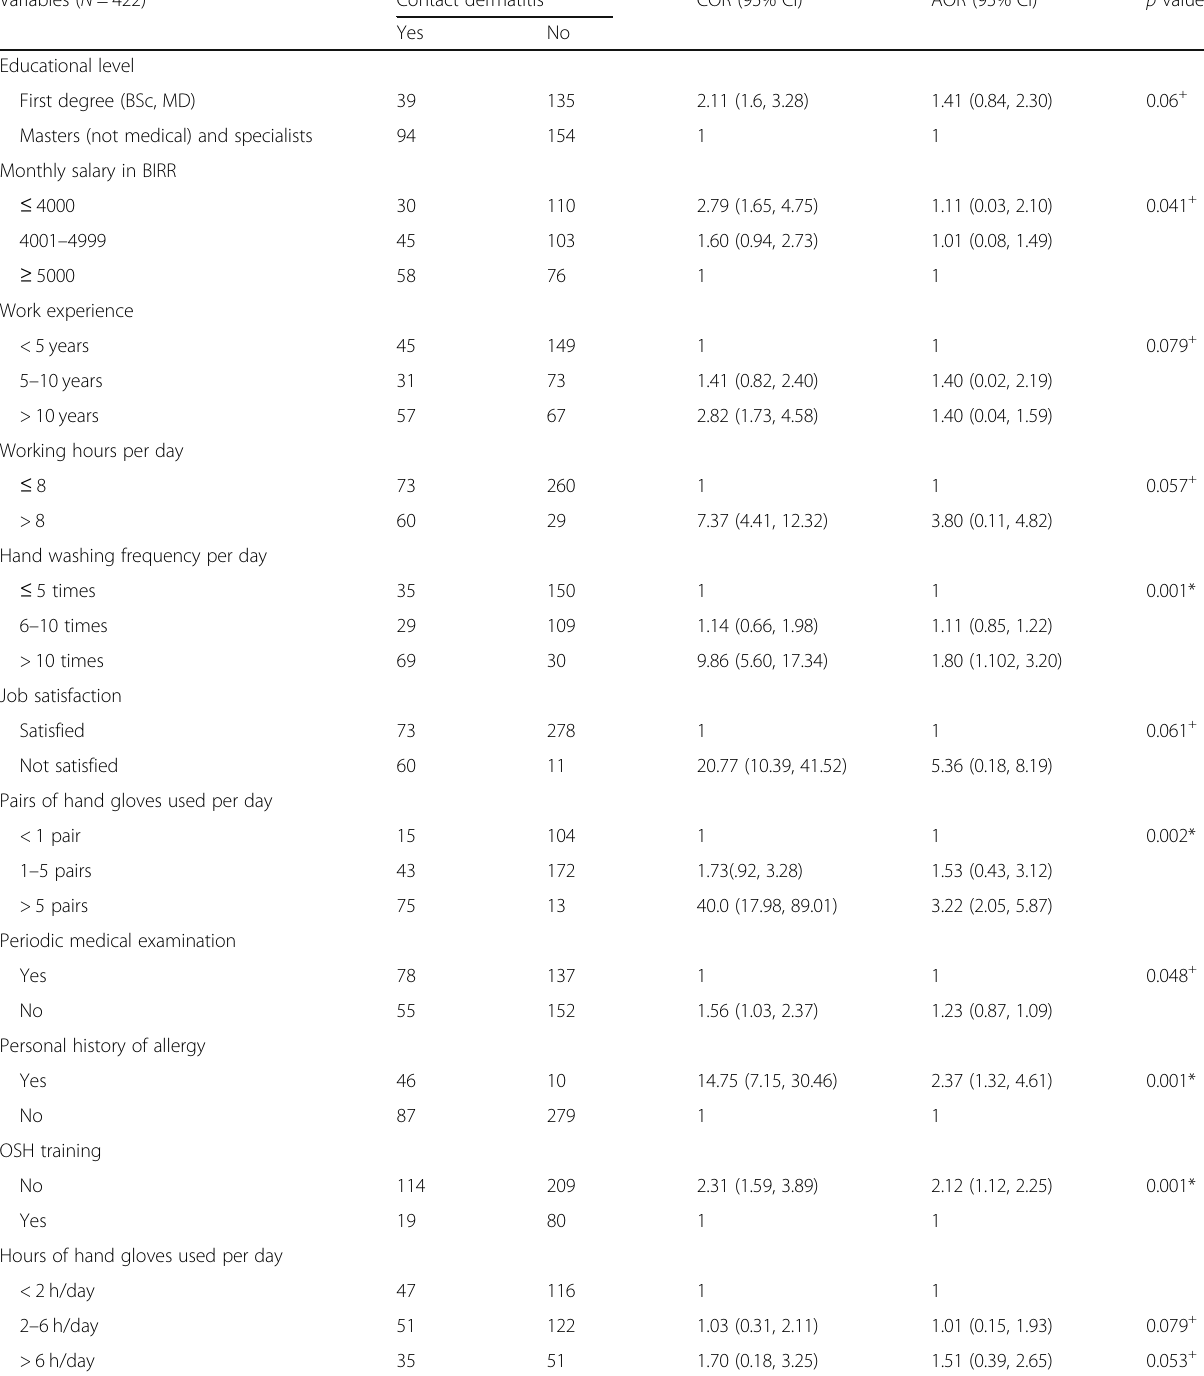
Table 2 Factors affecting occupational contact dermatitis (OCD) among HCWs, Gondar town, 2018,